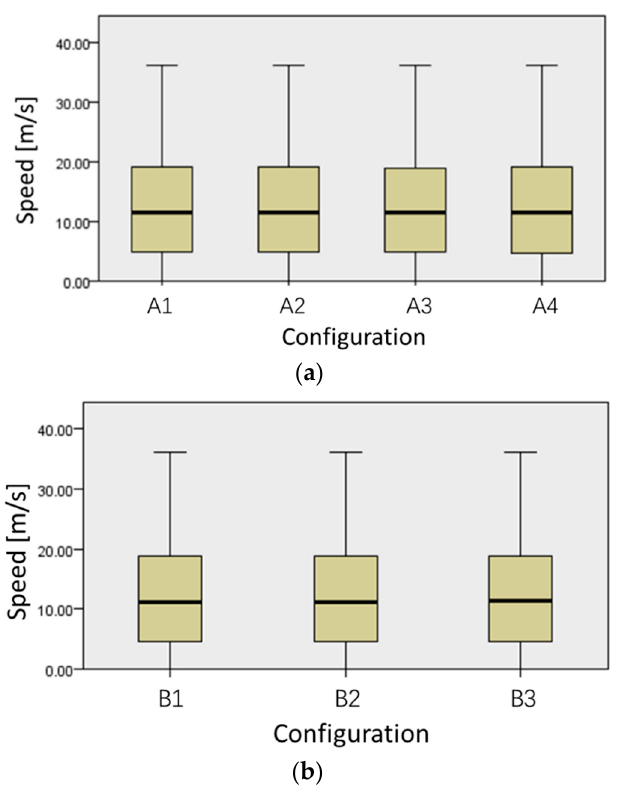
Figure 14. Box charts of vehicle speed under ( a ) Configurations A1–A4 and ( b ) Configurations B1–B3.